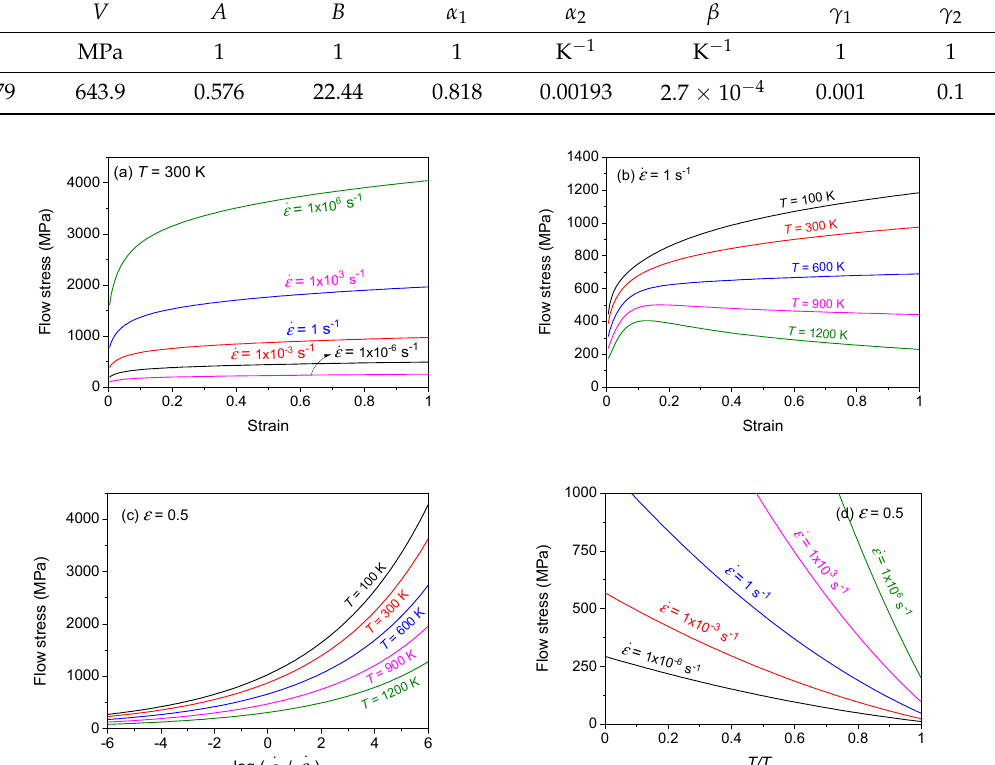
Figure 13. Flow stress–strain curves predicted for DP590 steel using the SKW model ( a ) at 300 K for different strain rates and ( b ) at 𝜀(cid:4662) = 1 for different temperatures. A change in flow stress at 𝜀 = 0.5 ( c ) with log ( 𝜀(cid:4662) / 𝜀(cid:4662) (cid:2868) ) for different temperatures and ( d ) with T / T m for different strain rates ( 𝜀(cid:4662) (cid:2868) = 1 s − 1 , 𝜀(cid:4662) ∗ = 1 s − 1 , 𝑇 0 = 298 K, T m = 1750 K).